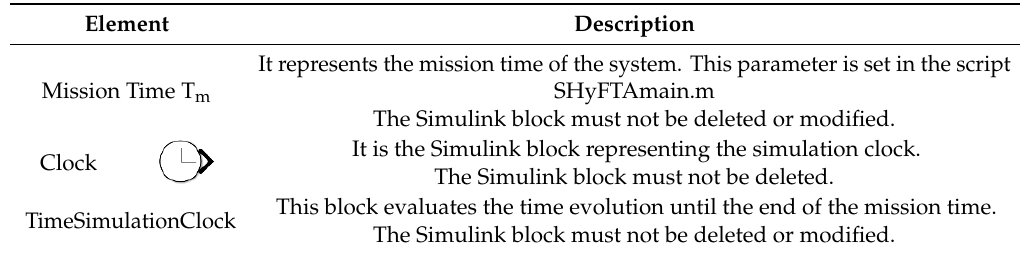
Table A1. Marking of the components of the ITER EVOLUTION Simulink block.